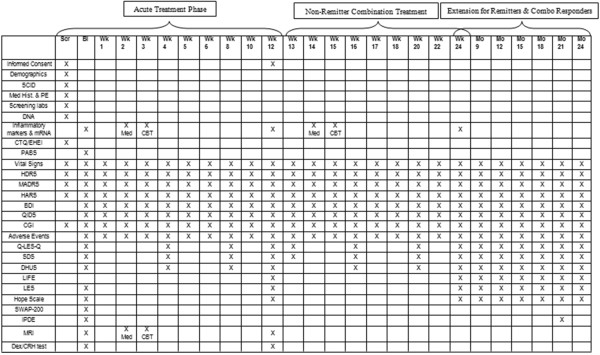
Schedule of events for PReDICT study. NOTE: Remitters to the acute (monotherapy) treatment phase enter into the extension follow-up phase beginning at week 12. BDI, Beck Depression Inventory; CGI, Clinical Global Impression; CTQ, Childhood Trauma Questionnaire: Dex/CRH, Dexamethasone Corticotropin Releasing Hormone test; DHUS, Daily Hassles and Uplifts Scale; DNA, Deoxyribonucleic acid; EHEI, Early Home Environment Interview; HARS, Hamilton Anxiety Rating Scale; HDRS, Hamilton Depression Rating Scale; IPDE, International Personality Disorders Examination; LES, Life Experiences Survey; LIFE, Longitudinal Interview Follow-up Evaluation; MADRS, Montgomery Depression Rating Scale; MRI, Magnetic resonance imaging; mRNA, Messenger ribonucleic acid; PABS, Patient Attitudes and Beliefs Scale; PE, Physical Exam; QIDS, Quick Inventory of Depressive Symptoms; Q-LES-Q, Quality of Life Enjoyment and Satisfaction Questionnaire; SCID, Structured Clinical Interview for DSM-IV; SDS, Sheehan Disability Scale; SWAP, Shedler-Westen Assessment Procedure, 2nd Ed.